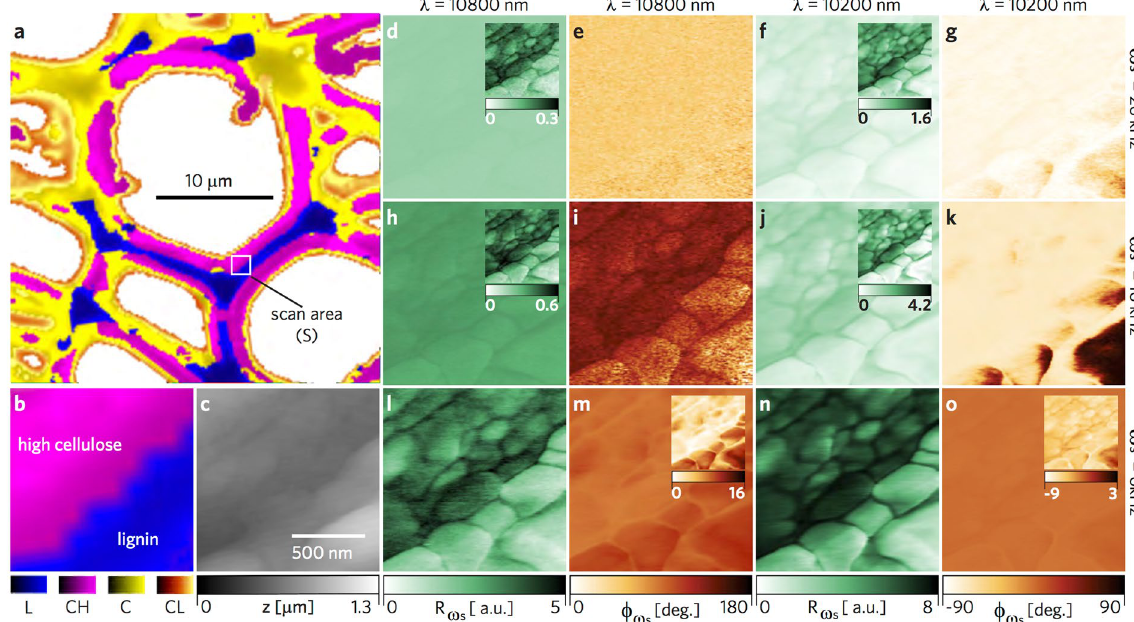
Figure 4. Photoacoustic force microscopy of cellulose and lignin. Employing PAS-AFM at a low absorption channel at λ = 10800 nm and a high absorption channel at λ = 10200 nm, the sample (EF) actuation rate was controlled from an amplitude modulated quantum cascade laser yielding sample oscillation frequencies = 26 KHz, 16 KHz, and 6 KHz. ( a ) Raman image independently identifying lignin and cellulosic content. The ω s square scan area marked as S locates the L–CH transition region over which images ( b – o ) were acquired. ( b ) Corresponding Raman image over region S. ( c ) Topography of S with contact mode AFM (height z). The amplitude ω R ( d , h , l ) and the corresponding phase Φ ω ( f , j , n ) responses at low absorption. The amplitude ω R s s s ( d , h , l ) and the corresponding phase Φ ω s ( f , j , n ) responses at high absorption. Each image group in the right four columns (images ( d – o )) maintains the same scale. The insets display the substructures at the highest contrast, although the signals are weaker. Lower sample actuation frequency yields a stronger signal in accordance with the sample relaxation; distinction between the material domains is amplified at high